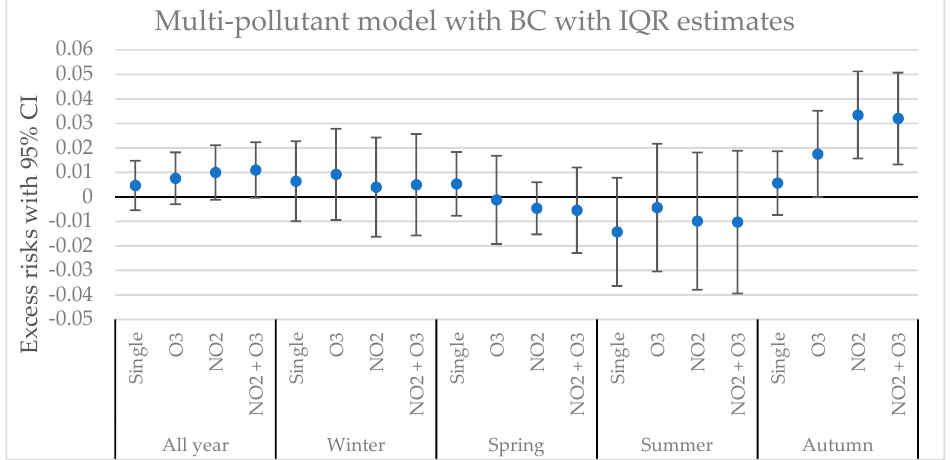
Figure 4. Estimated excess risks in daily mortality with 95% CI (lag02) for an IQR increase in the concentrations of BC. The calculations are divided into all year and four different seasons. The excess risks are presented as single ‐ pollutant estimates and multi ‐ pollutant estimates with O 3 , NO 2 and NO 2 + O 3 included in the calculations .